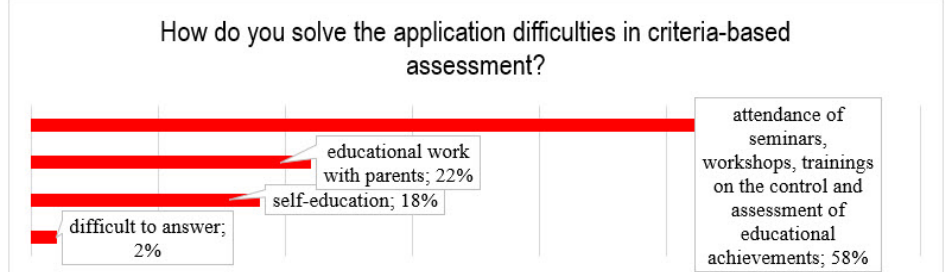
Figure 4. How do you solve the difficulties of applying criteria-based assessment?